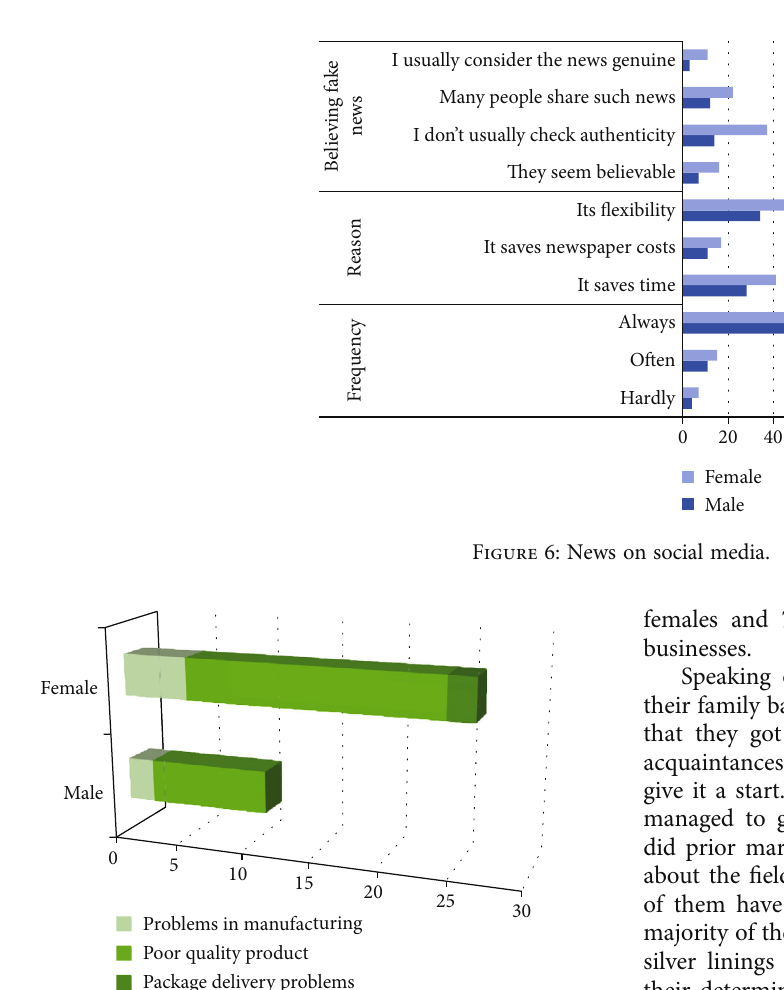
Figure 7: Causes of bad